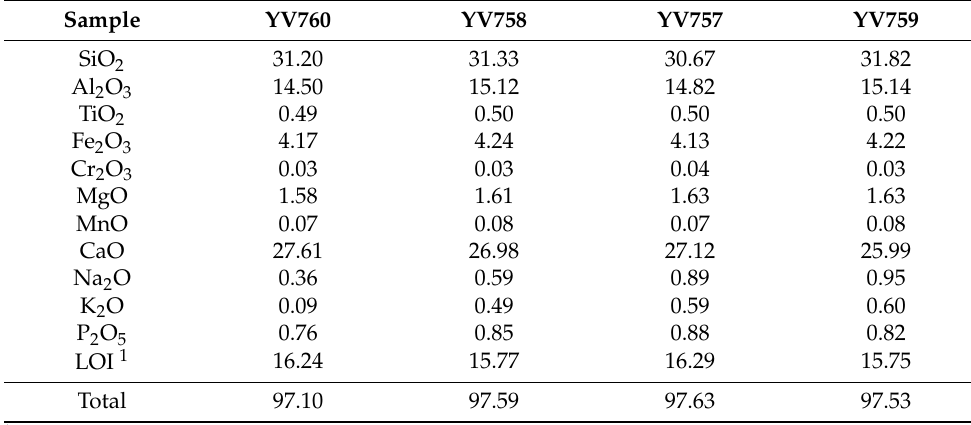
Table 1. Major chemical composition of the zeolite-bearing rock